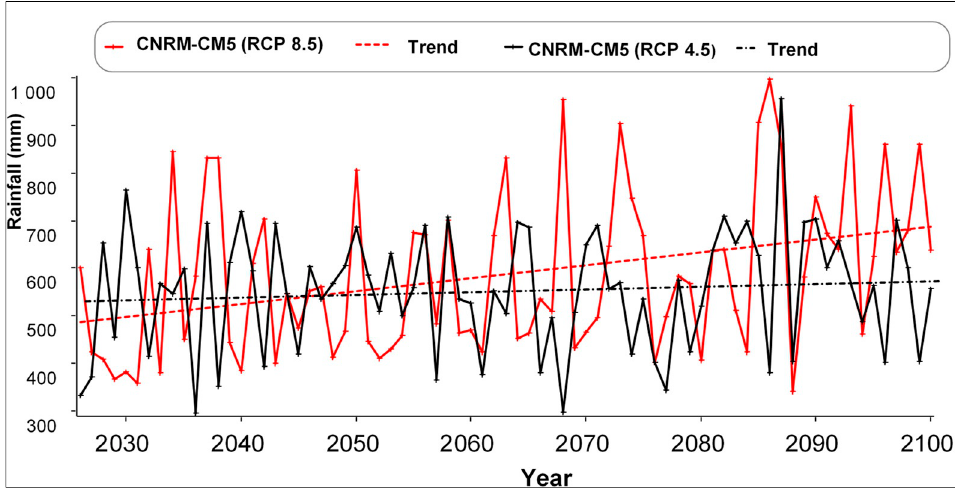
Figure 3. The annual rainfall from 2026 to 2100 for CNRM-CM5 model under RCP 4.5 and 8.5 scenarios. The Intergovernmental Panel on Climate Change (IPCC) [58] reported frequent and intensive occurrence of extreme events such as droughts, under both RCP 4.5 and RCP 8.5. For example, IPCC [58] forecasted (with 66% certainty) that droughts will become